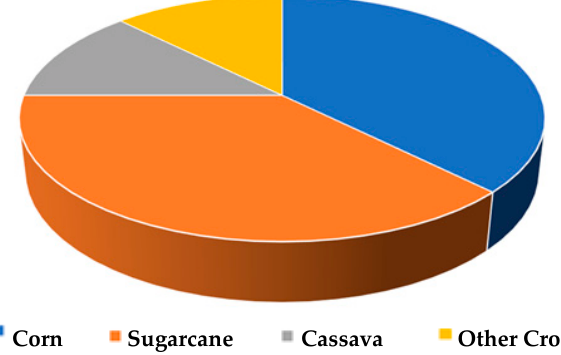
Figure 1. The global lactic acid market share, by raw material, 2017 [38].